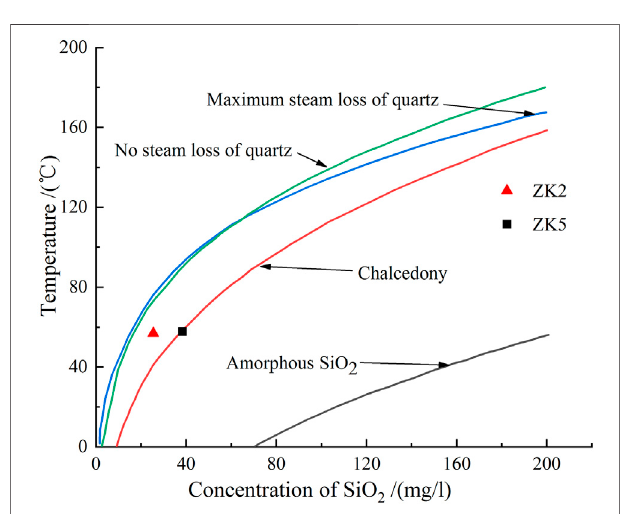
FIGURE 11 | Solubility curve of SiO 2 .